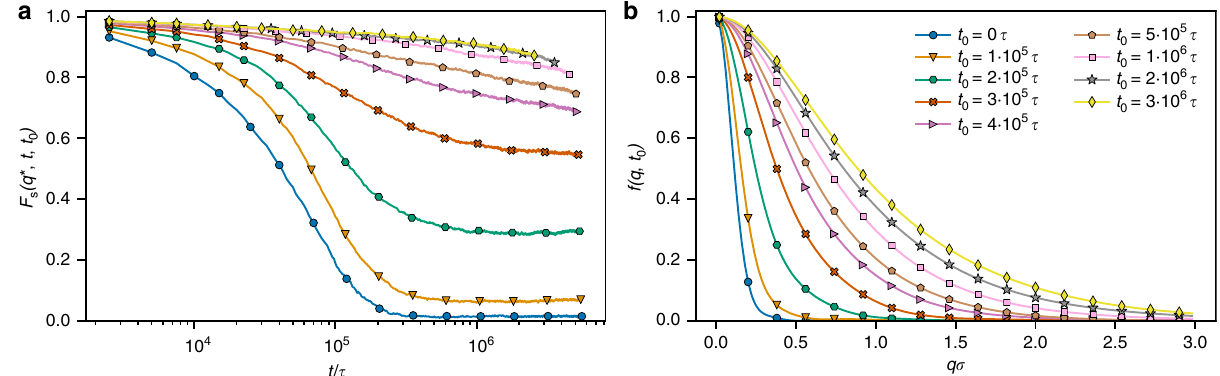
(cid:5) σ ¼ 0 : 35. b Non-ergodicity 0 at q